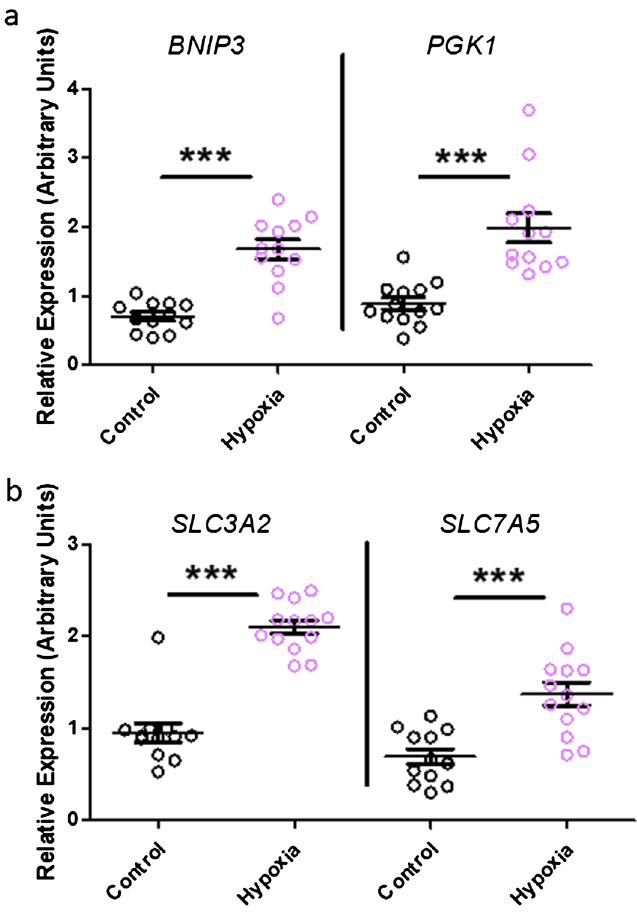
Figure 1. Candidate gene expression following control (black) and hypoxia (pink) conditions in the forebrain slice culture model. ( a ) Hypoxia resulted in an increased expression of the classic hypoxia response genes, BNIP3 and PGK1. ( b ) Hypoxia also resulted in an increased expression of SLC3A2 and SLC7A5. *** indicates p < 0.001, comparisons were made using an independent t-test followed by a Bonferroni p-value adjustment for multiple comparisons. Expression was normalised to TBP. Error bars indicate standard